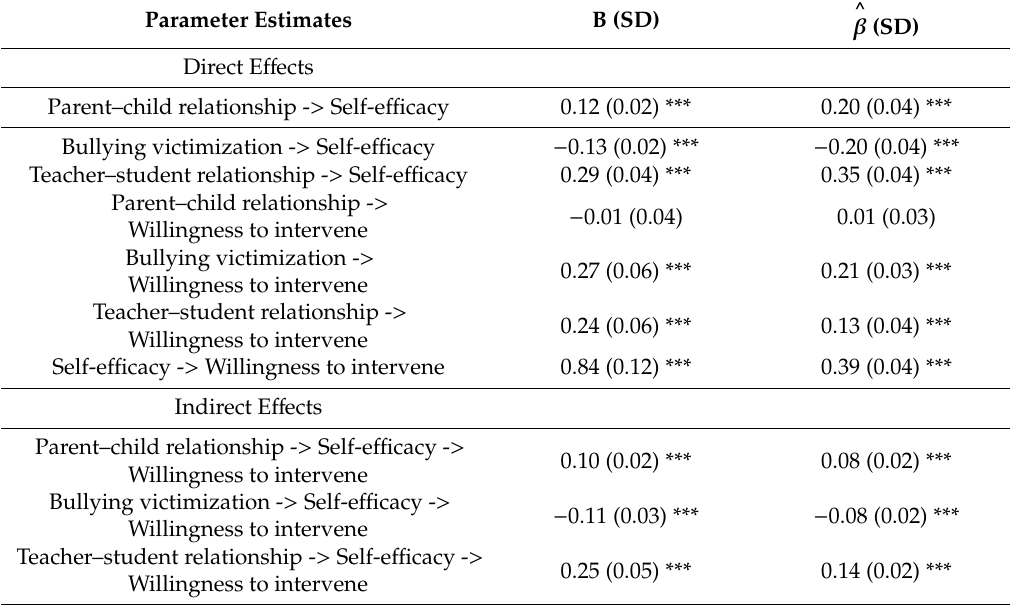
Table 3. Unstandardized coe ffi cients ( B ), standardized coe ffi cients ( parentheses) for the mediation